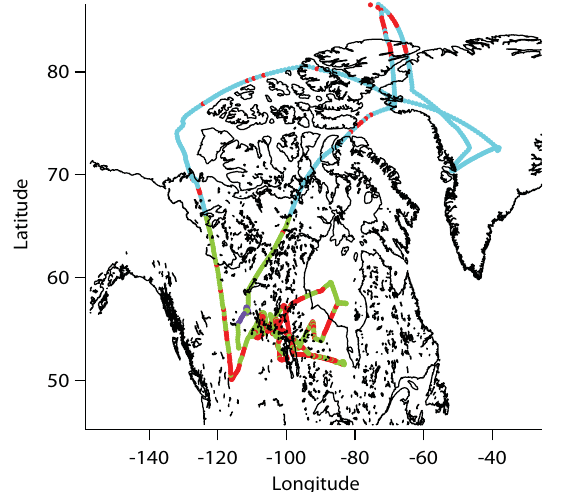
Fig. 1. Aircraft flight trajectories for the research flights of ARCTAS-B on the NASA DC-8, colored by air mass source type. Red colors denote biomass burning, green colors denote boreal for- est background, blue colors denote Arctic background, and purple colors denote anthropogenic industrial